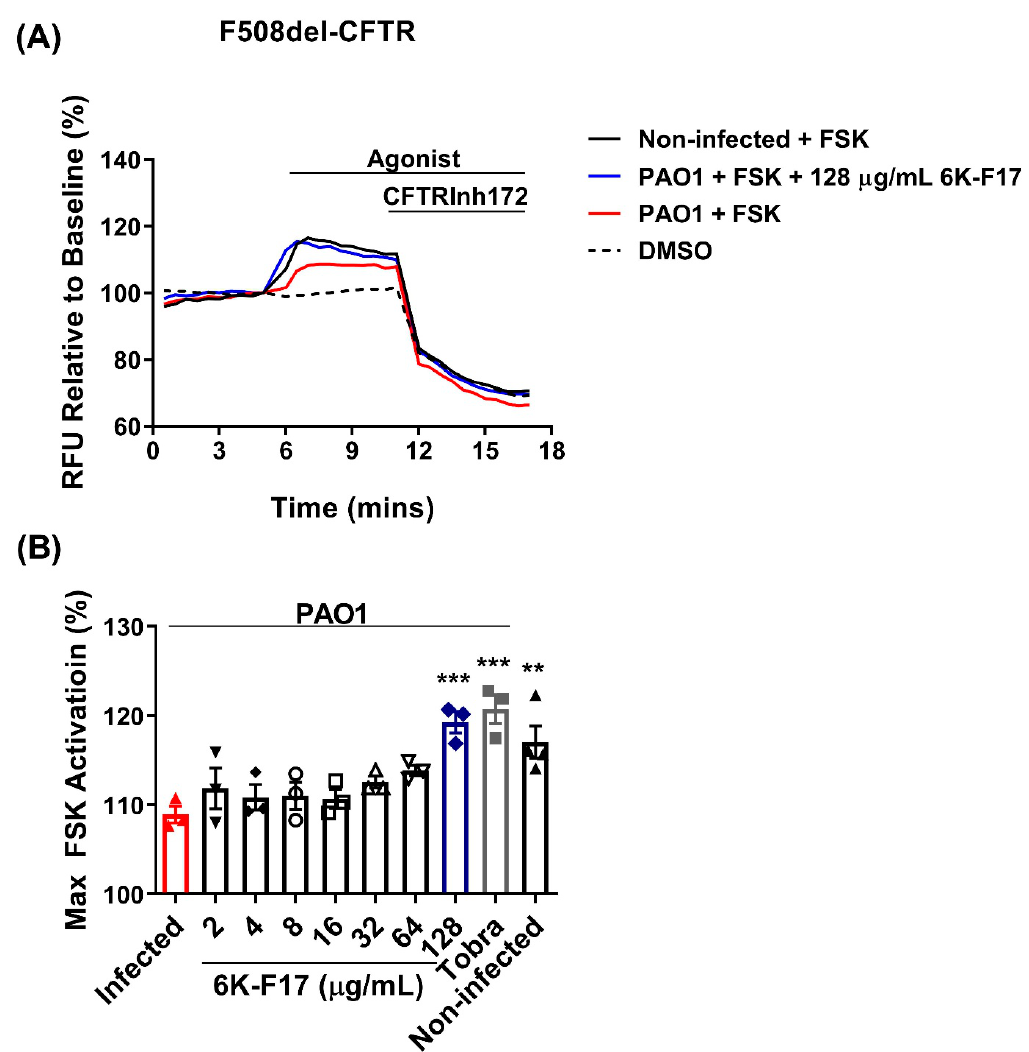
Figure 3. 6K-F17 restores F508del-CFTR channel activity in human bronchial epithelial cells infected with P. aeruginosa . ( A ) Representative traces of F508del-CFTR-dependent chloride e ffl ux using the membrane depolarization assay. F508del-CFTR HBE cells were incubated with PAO1 +/ − 6K-F17 peptide (0–128 µ g / mL) or tobramycin (10 µ g / mL) for 4 hr. Following a 5 min. baseline measurement, 10 µ M FSK + 1 µ M VX-770 was added. After 10 min, CFTR inhibitor (CFTRinh-172, 10 µ M) was added to deactivate CFTR, as noted by the change in the slope of the curves. ( B ) Bar graphs show the mean ( ± SEM) of maximal activation of CFTR after stimulation by FSK + 1 µ M VX-770 ( n = 3–4; each dot represents one biological replicate). (** p < 0.01, *** p < 0.001).